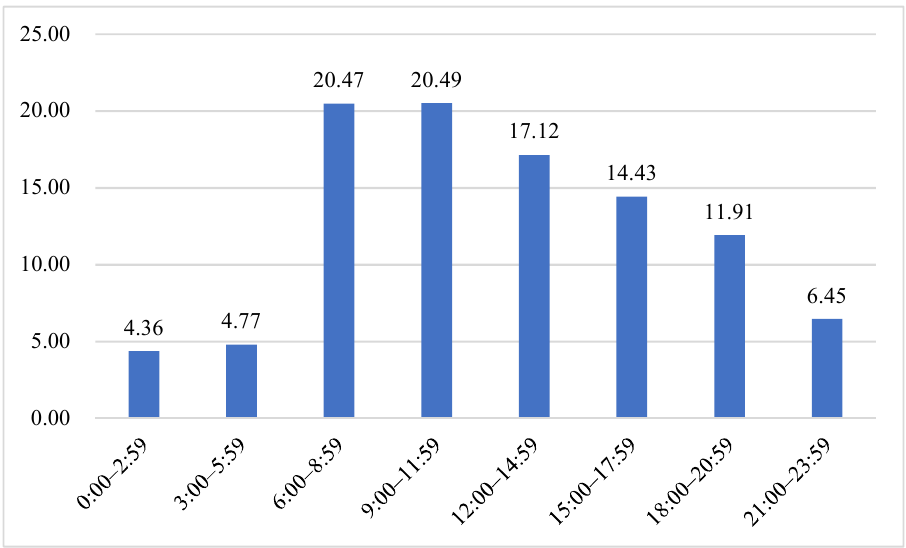
Figure 6. Percentage distribution of emergency calls by hours of the day.